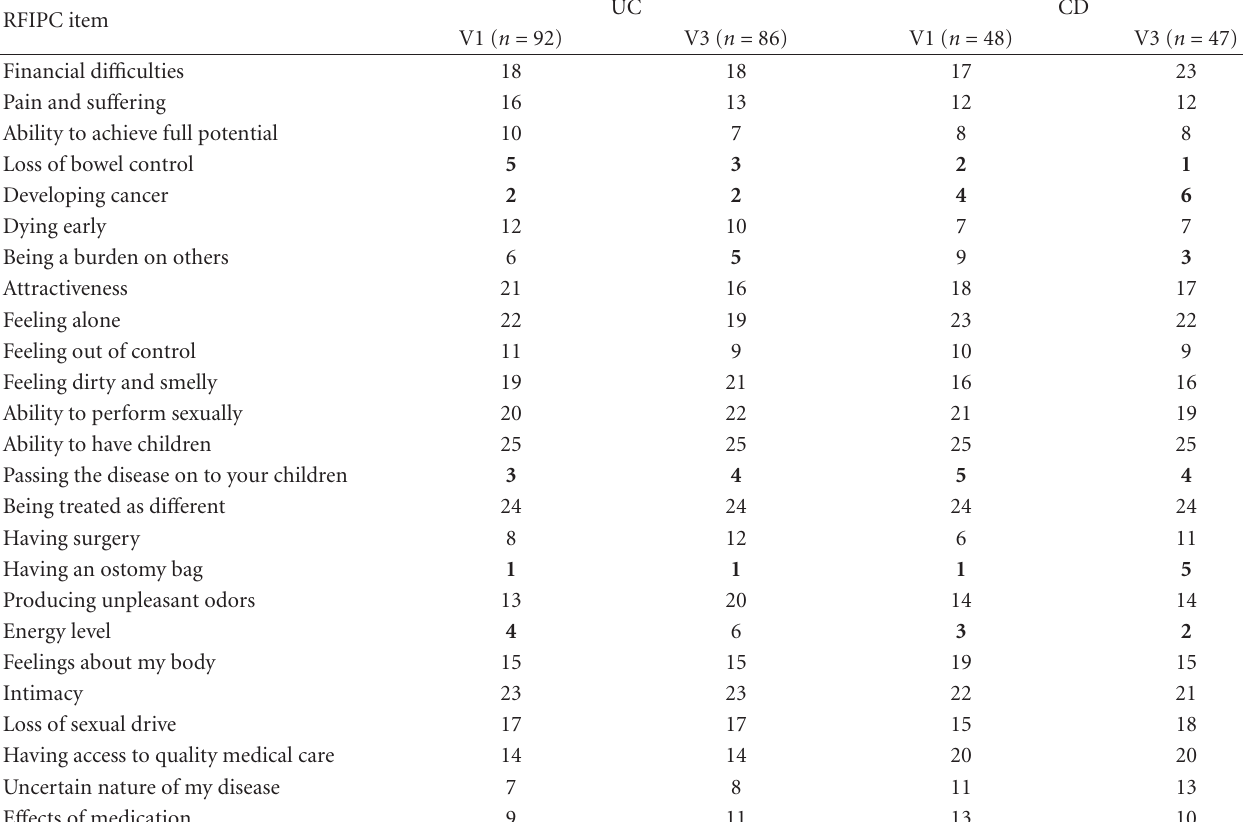
Table 2: Numerical ranking of disease-related worries and concerns among IBD patients followed for 1-Year (items ranked as the five most important are in